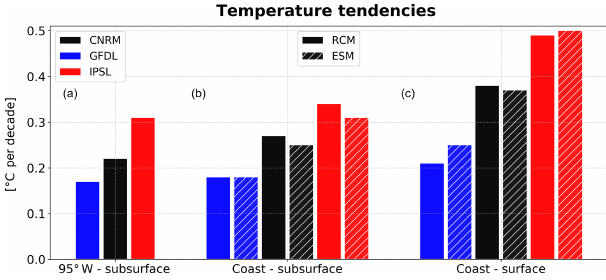
Figure 8. Depth-averaged RCM and ESM temperature linear trends between 2006 and 2100 ( ◦ C per decade) in the equatorial region (95 ◦ W, 2 ◦ N–10 ◦ S, 50–200m, a ), in the coastal region (b) , and in the surface layer (0–5m, c ). CNRM, GFDL, and IPSL trends are shown in black, blue, and red, respectively, and ESM trends are shown with